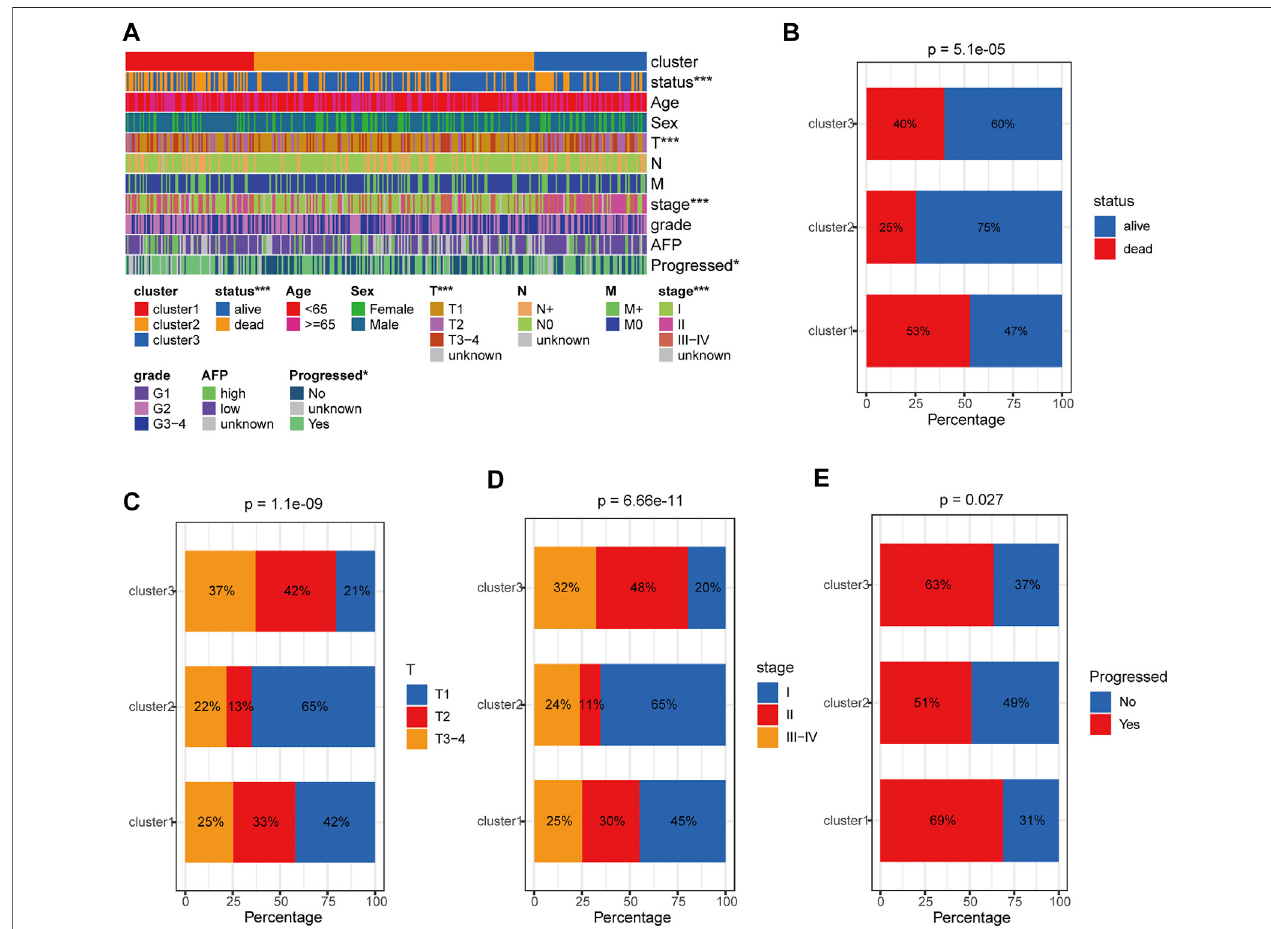
FIGURE 3 | Clinical correlation analysis of HRDELs-speci fi c clusters in TCGA-LIHC cohort. (A) Distribution landscape of HRDELs-speci fi c clusters among clinical characteristics. Comparison of distribution difference of overall survival status (B) , pathological T (C) , AJCC stage (D) , and “ Progressed (Yes/No) ” (E) among HRDELs -speci fi c clusters. HRDELs: hypoxia-related differentially expressed lncRNAs. AJCC: American Joint Committee on Cancer. ***, p < 0.001; **, p < 0.01; *, p <